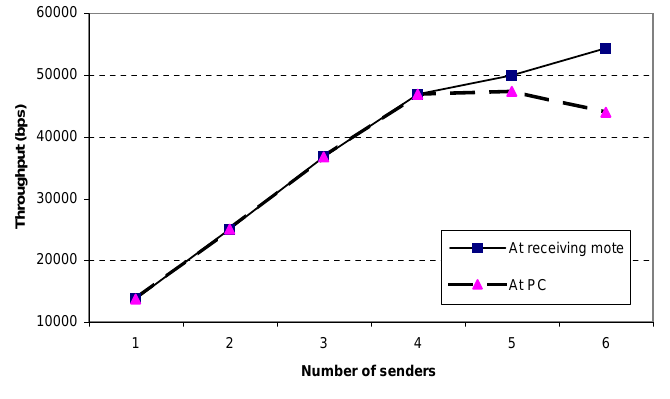
Figure 11. Aggregate throughput at receiving mote and PC as a function of the number of senders (maximum possible sending